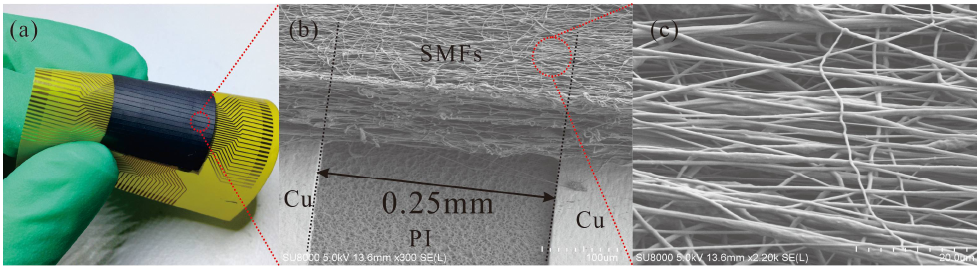
Figure 6. ( a ) A photo of proposed flexible tactile sensor with 0.5 mm central distance of electrodes (CDoE); ( b ) An SEM image of SMFs between two Cu electrodes; ( c ) A higher amplification SEM image of SMFs to show the alignment.